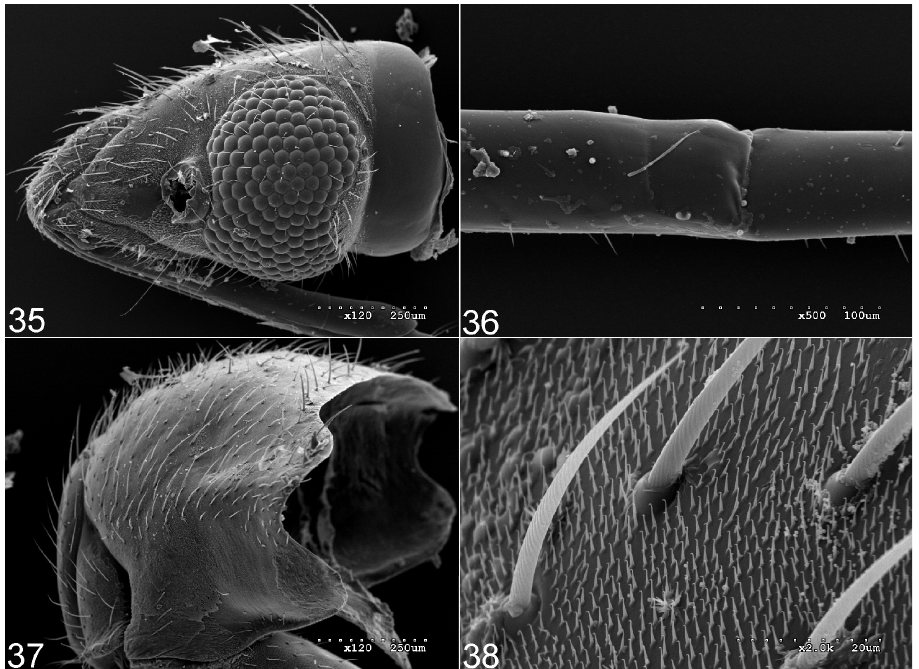
Figures 35–38. Scanning electron micrographs of Fulvius tumidipennis . 35 Head (left lateral view) 36 Subdivision of labial segment II 37 Pronotum 38 Texture and vestiture of pronotum. Remarks. Fulvius tumidipennis is most similar to F. flavicornis and F. subnitens